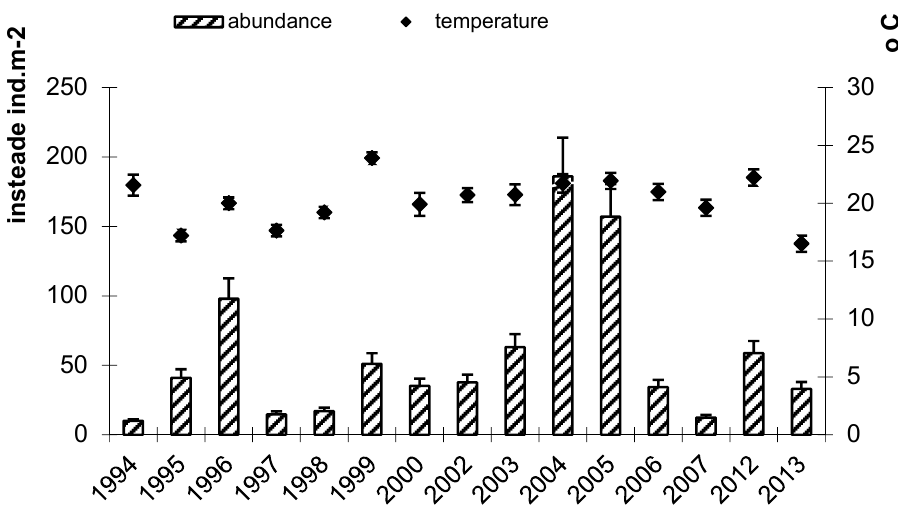
Figure 6. Long-term dynamics of Bithynia troschelii abundance and water temperature in the Kargat River estuary in 1995–2013 (only in the second 10-day period of June).